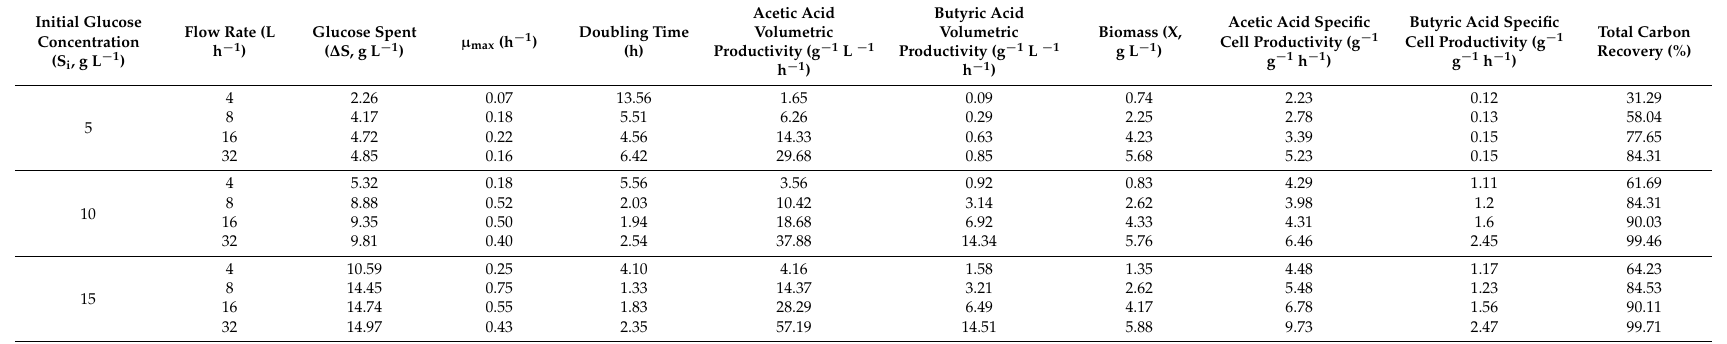
Table 2. Performance of C.butyricum (carboxylic acid productivity, biomass generation, glucose consumption, carbon recovery) in a MBR fed-batch culture system. Initial Glucose Concentration (S i , g L − 1 )